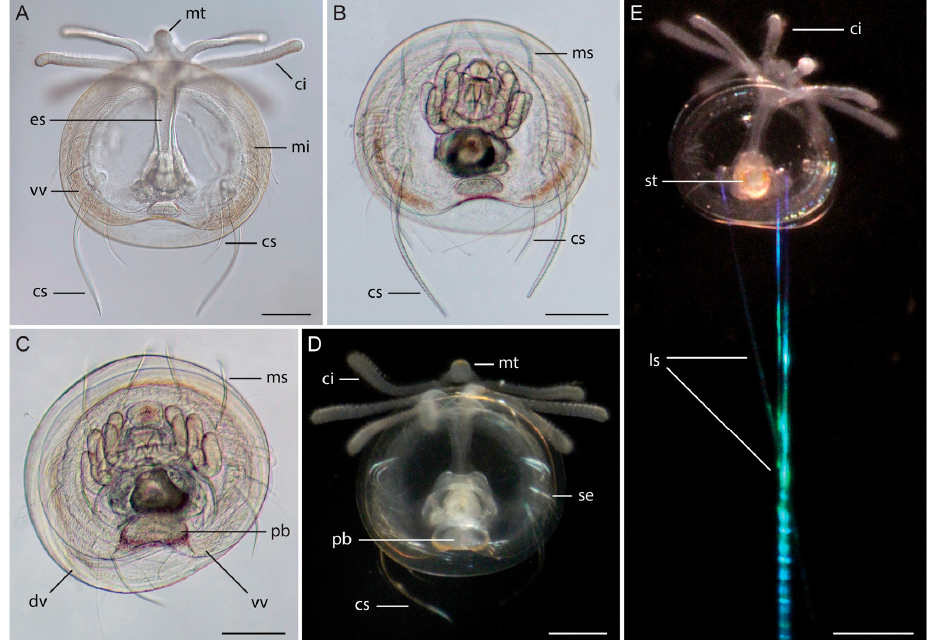
Figure 1. Larval discinids from the Pacific and Caribbean coasts of Panama. ( A ) Larva in operational taxonomical unit (OTU)3 from Bocas del Toro; ( B ) Larva in OTU3 from the Bay of Panama; ( C ) Larva in OTU4 from the Bay of Panama; ( D ) Darkfield micrograph of larva in OTU4 from the Bay of Panama; ( E ) Young larva from Bay of Panama with long iridescent larval setae. No sequence data was generated for this specimen. Abbreviations: ci, cirri; cs, curved seta; ds, dorsal valve; es, esophagus; ls, larval setae; mi, minor setae; ms, major setae; mt, median tentacle; pb, pedicle bud; se, seta; st, stomach; vv, ventral valve. Scale bars = 100 μ m.